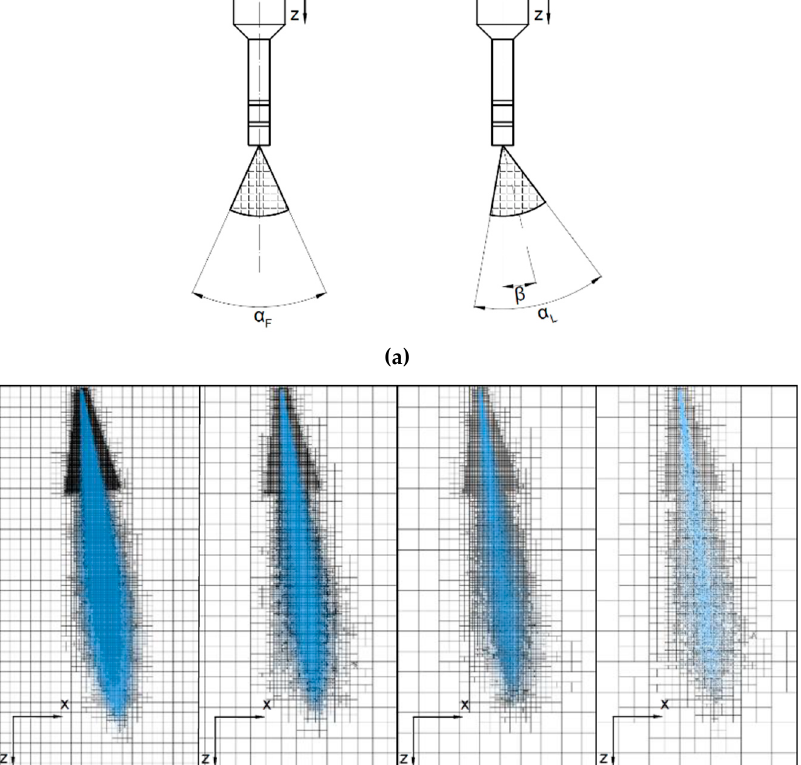
(b) Figure 3. Comparison of simulated and measured droplet diameters at various transverse locations at 15 mm from the tip under conditions specified in Table 3. ( a ) average diameter (D10); ( b ) predicted SMD (D32). 3.2. Port Water Injector Similarly, the GDI injector has been tested in a constant volume chamber, under the conditions shown in Table 4. In the vessel experiments the test fuel is Exxsol-D40, whose properties have been represented with an ad-hoc surrogate created only for the scope of this validation. Specifically, liquid phase properties have been prescribed to match density, viscosity, heat of vaporization, specific heat and surface tension in the range of temperatures of interest. Vapor phase has been modeled as iso- octane. Figure 4 shows a visual comparison between the simulated spray and the experimental imaging. The bottom-right figure, obtained via laser sheet imaging, allows to determine the actual directions of the jets, an essential information for the Lagrangian spray model, as in this type of injectors jets emerging from each hole depart considerably from the nominal drilled direction. Observing both the frontal and the side views, the comparison between the measured and simulated spray morphology were considered adequate. In addition, as for the water injector case, validations